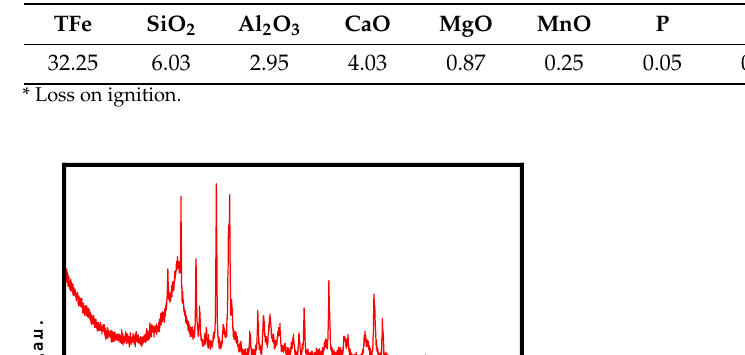
Table 1. The main chemical composition of BF dust, wt.%.